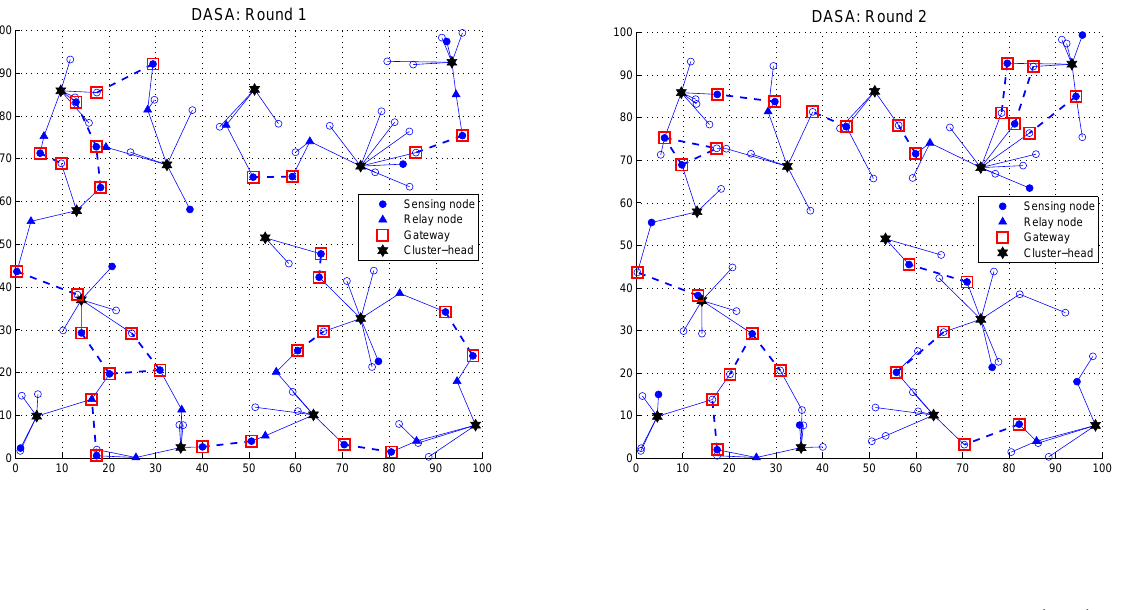
Figure 23. Memory usage of sensor nodes in a cluster versus number of sensors N memory usage of a clusterhead versus number of sensors N